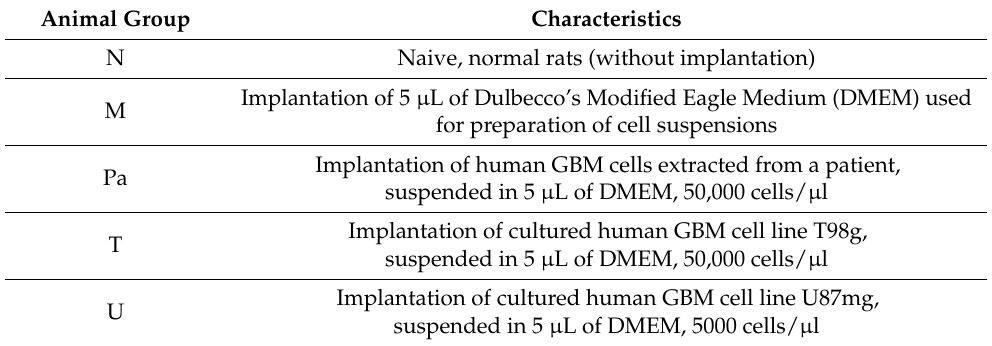
Table 2. Characteristics of examined animal